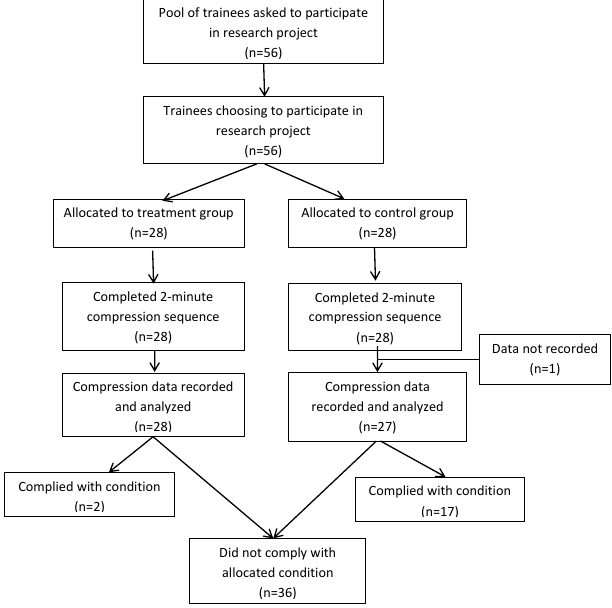
Figure 2. CONSORT flow